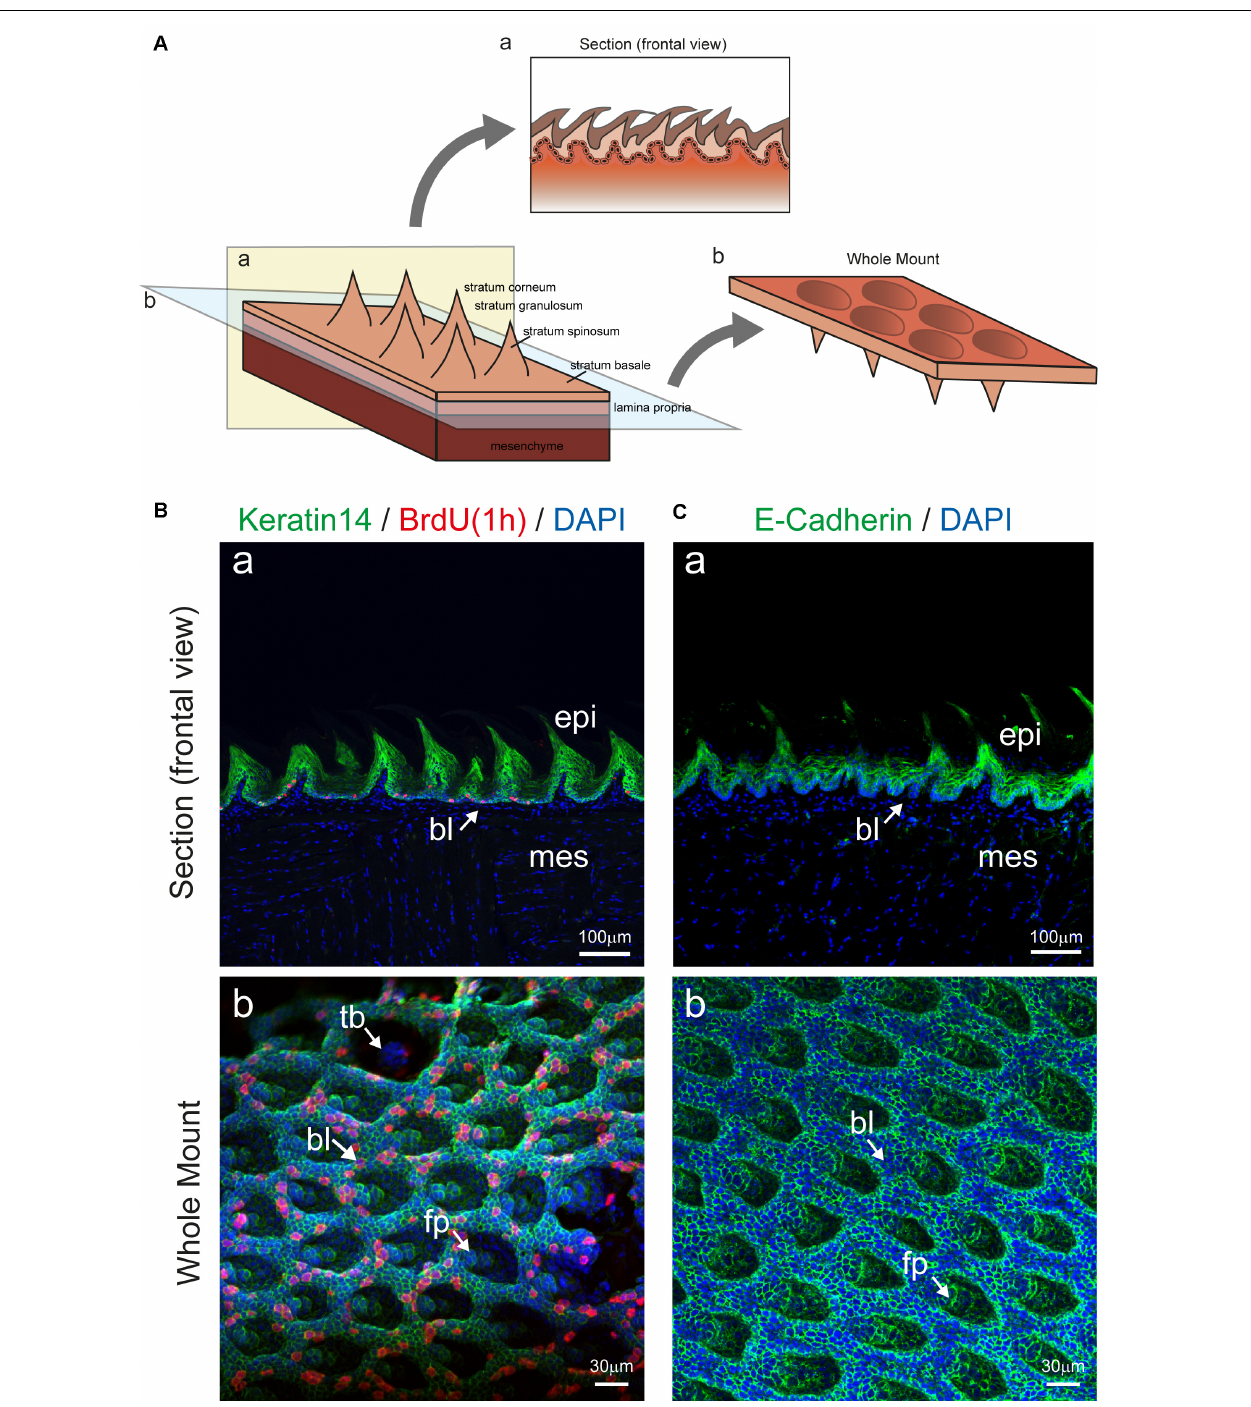
FIGURE 2 | Imaging of tongue epithelial explant. (A) Schematic representation of the dorsal part of the tongue with epithelial and mesenchymal components. Panel a (yellow color) shows a section, displaying the mesenchyme, the lamina propria, and the epithelium with its different compartments. Plane b (blue color) depicts the location of mesenchyme and epithelial separation upon enzymatic digestion. The prospective rotation represents the exposed basal portion of the epithelium. (B) (a) Section of the tongue stained for Keratin14 (green), BrdU (red), and DAPI (blue). Arrow indicates the basal epithelial layer. (b) Whole mount immunofluorescent staining for Keratin 14, BrdU and DAPI of the isolated tongue epithelium. Arrows indicate important structures in the epithelium. (C) (a) Section of the tongue stained for E-Cadherin (green) and DAPI (blue). Arrow indicates the basal epithelial layer. (b) Whole mount immunofluorescent staining for E-cadherin and DAPI of the isolated tongue epithelium. Arrows indicate important structures in the epithelium. Abbreviations: bl, basal layer; epi, epithelium; fp, filiform papillae; mes, mesenchyme; tb, taste bud. Scale bars: Ba, Ca: 100 µ m; Bb, Cb: 30 µ m.